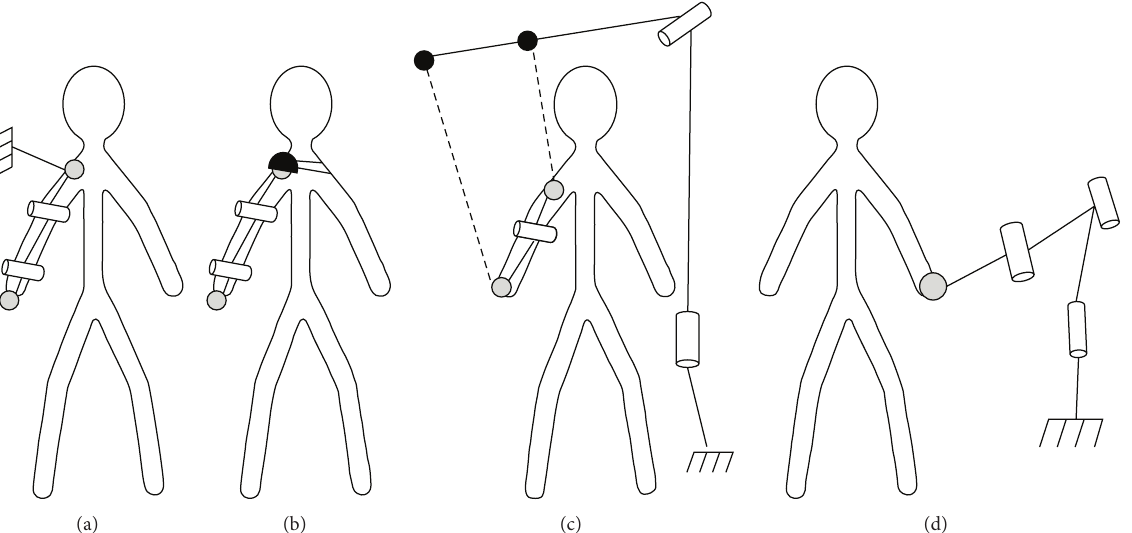
Figure 1: Mechanical categories of upper limb rehabilitation robots. (a) Semiexoskeleton with fixed base. (b) Mobile exoskeleton (haptic interface). (c) Wire based. (d)